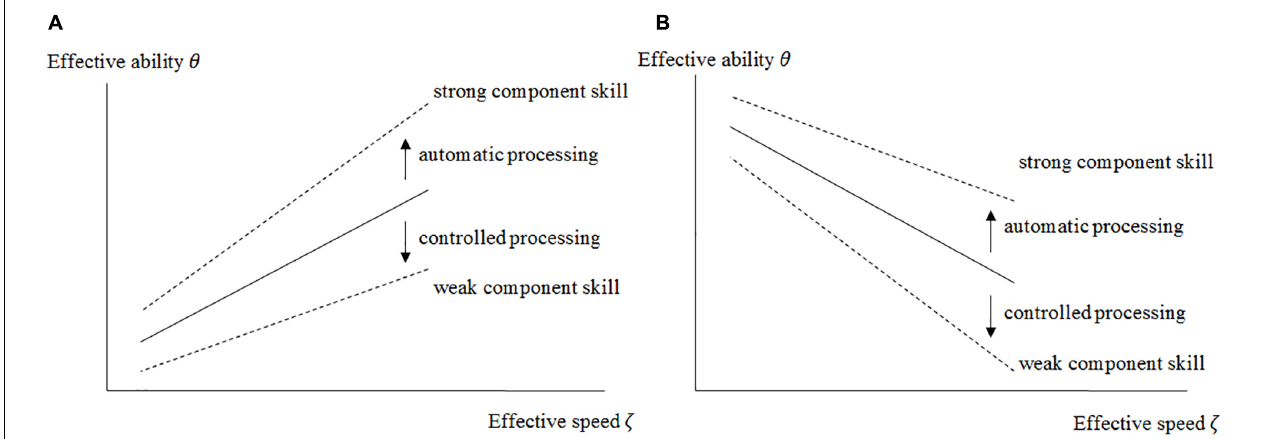
FIGURE 1 | Illustration of the relation of effective speed to effective ability at the between person level ( A: positive relation, B: negative relation). The upper/lower dashed line indicates how a strong/weak construct-related component skill is expected to moderate the speed-ability relation. For persons with strong component skill it is expected to be more positive and less negative, respectively (and vice